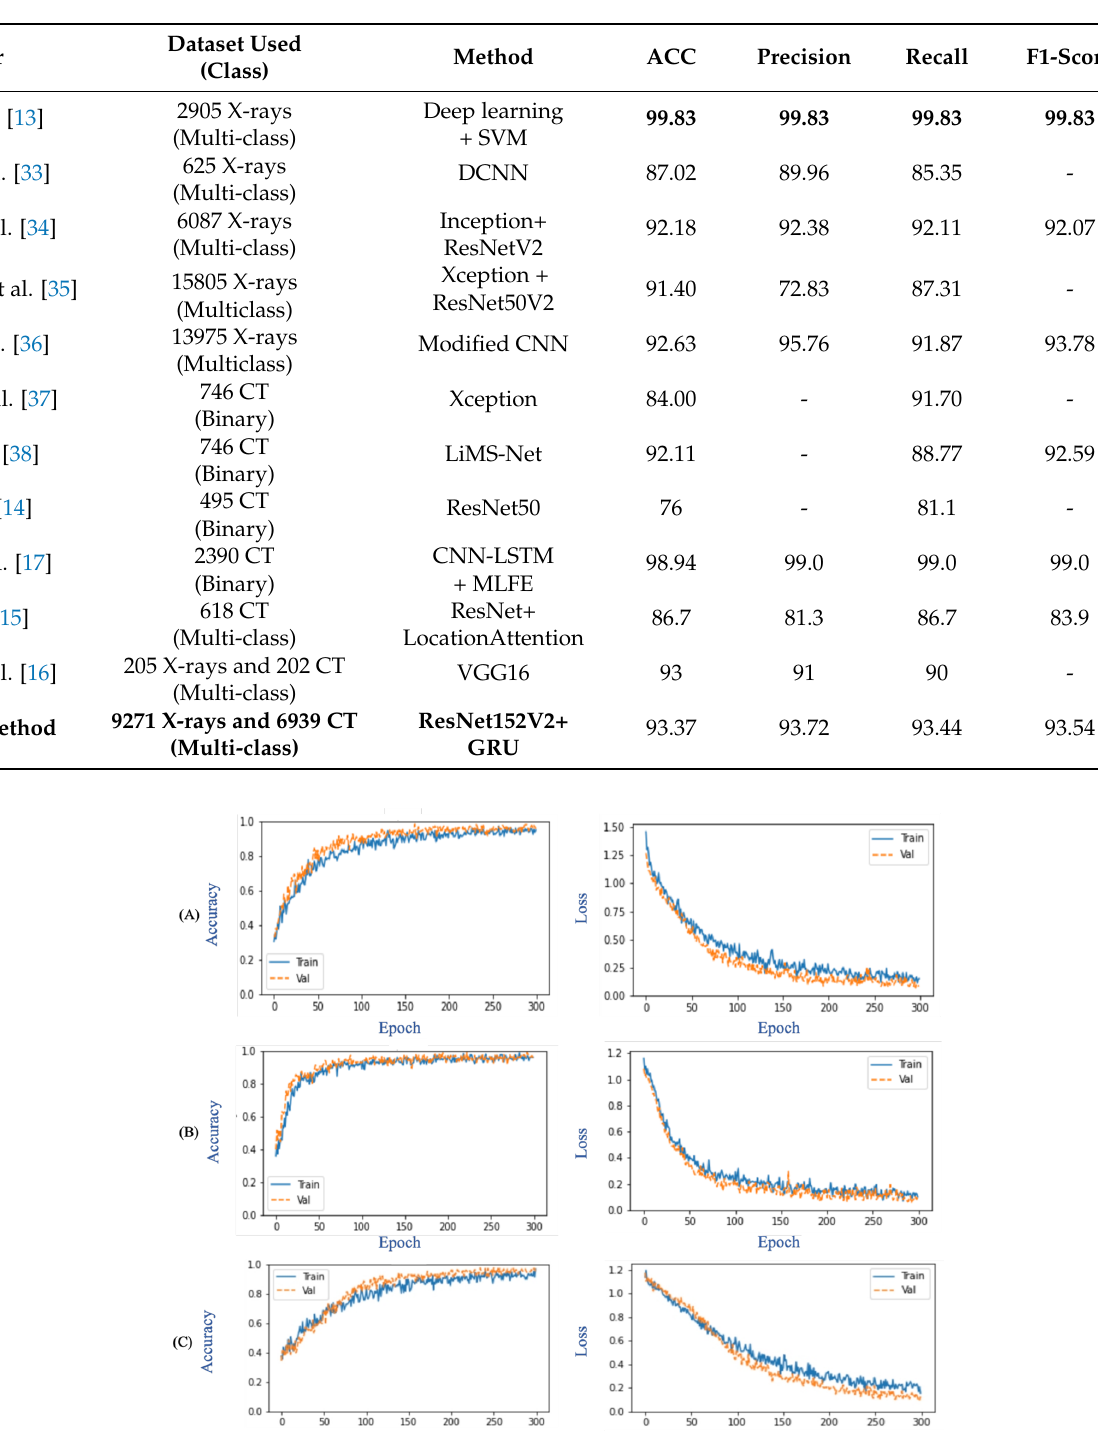
Table 3. Comparison of results obtained in this study with other methods in the literature.